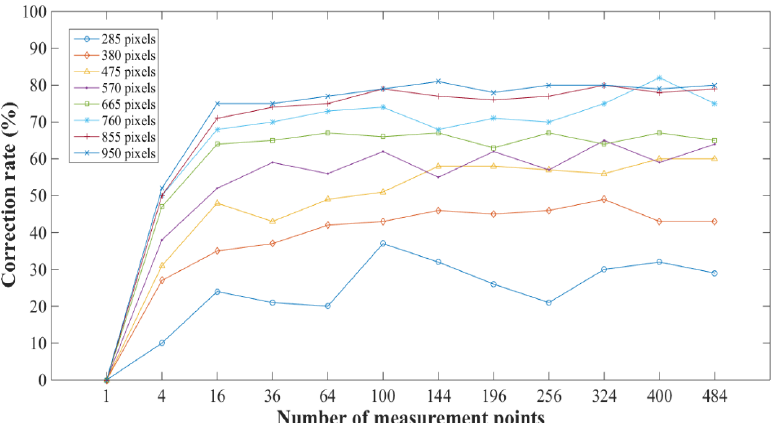
Figure 6. RMSE correction rates of displacement measurement results after optical-turbulence error mitigation for different targets.